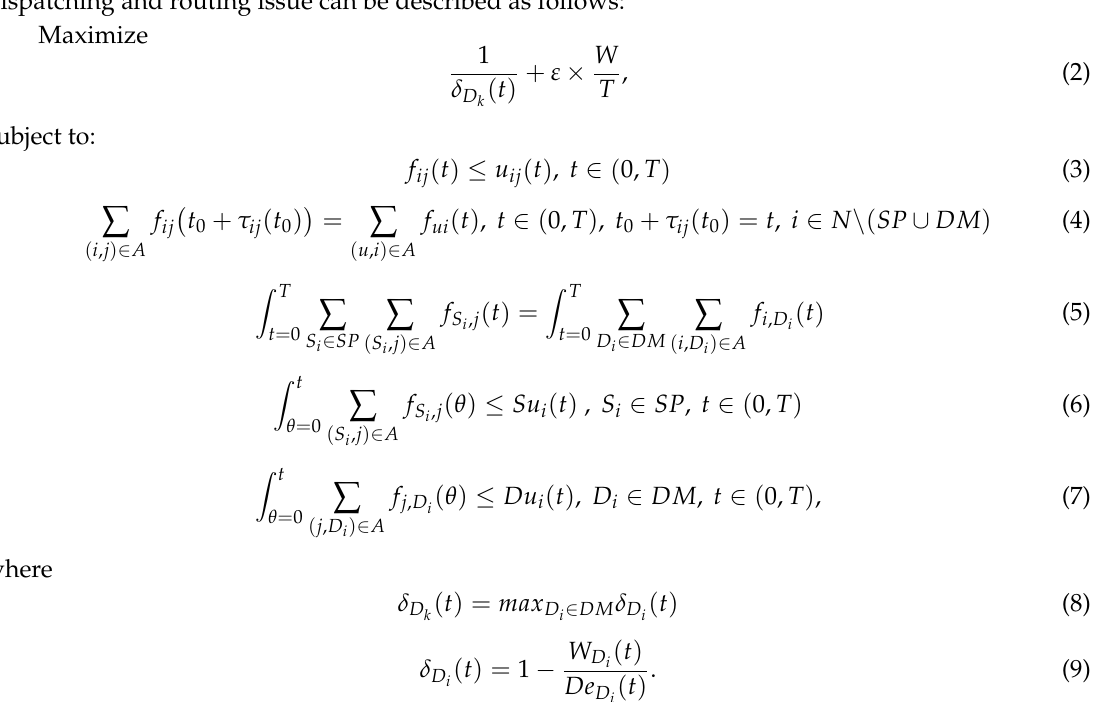
Figure 3. Flowchart of constructing a multi-objective multi-dynamic-constraint EMVDR model.